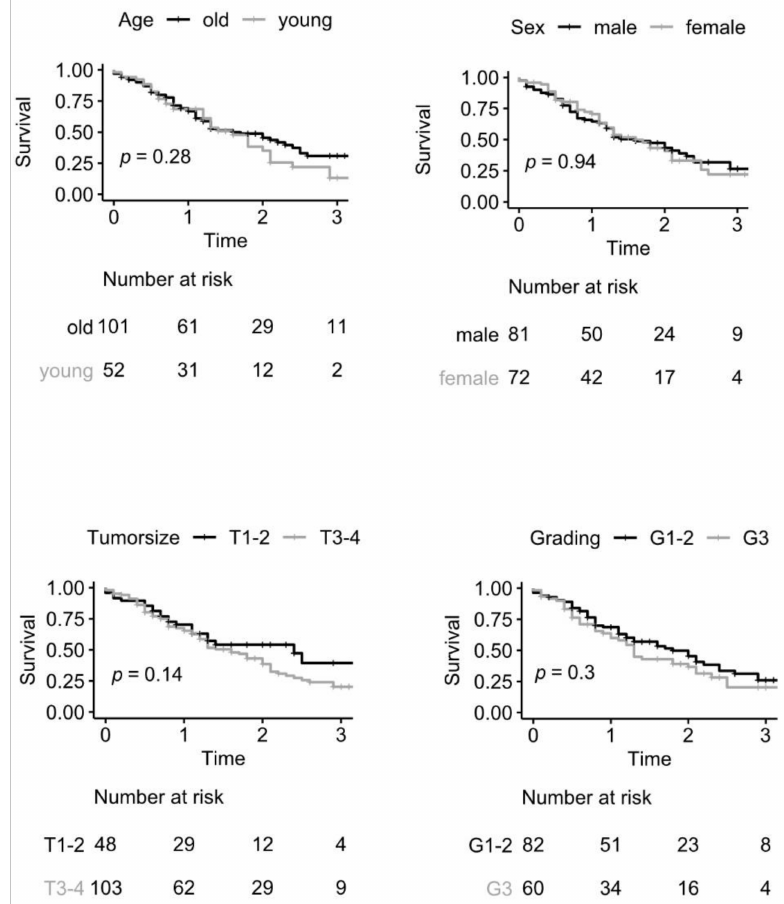
Figure 1. Kaplan–Meier estimates of overall survival stratified by resection margin (R0 vs. R1, p = 0.0079), successful completion of adjuvant chemotherapy ( p < 0.0001), lymph nodes (N0 vs. N+, p = 0.02), age (old ( ≥ 65 years) vs. young (<65 years), p = 0.28), sex (female vs. male, p = 0.94), tumor size (T1–2 vs. T3–4, p = 0.14), and grading (G1–2 vs. G3, p =